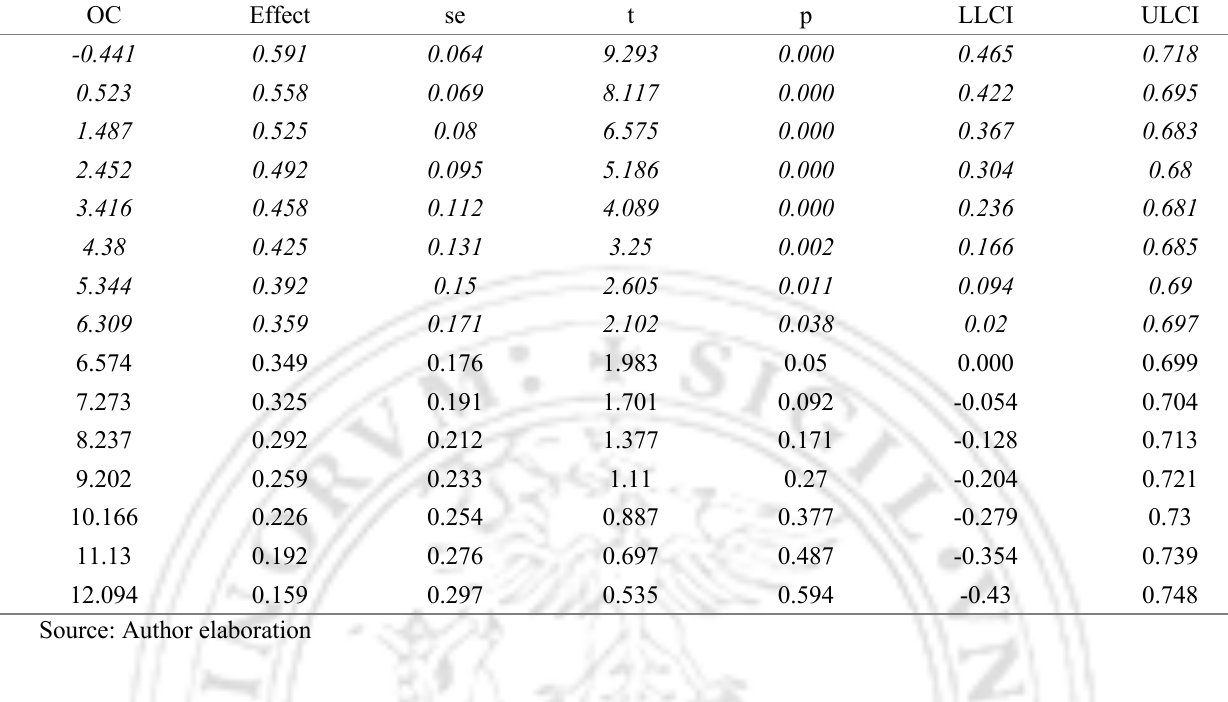
Figure 4 Moderating effect of Organizational